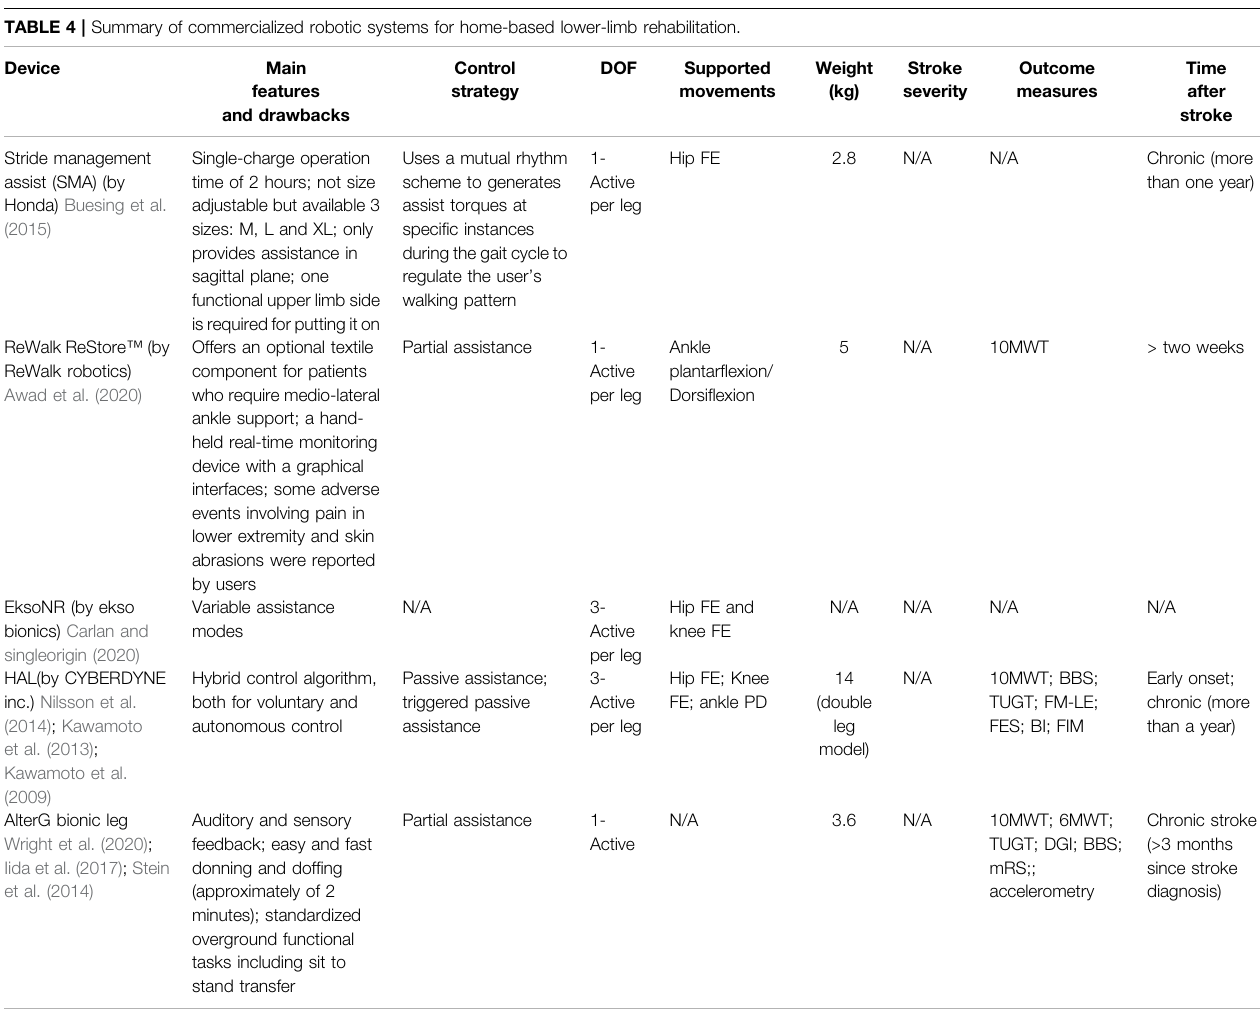
TABLE 4 | Summary of commercialized robotic systems for home-based lower-limb rehabilitation.